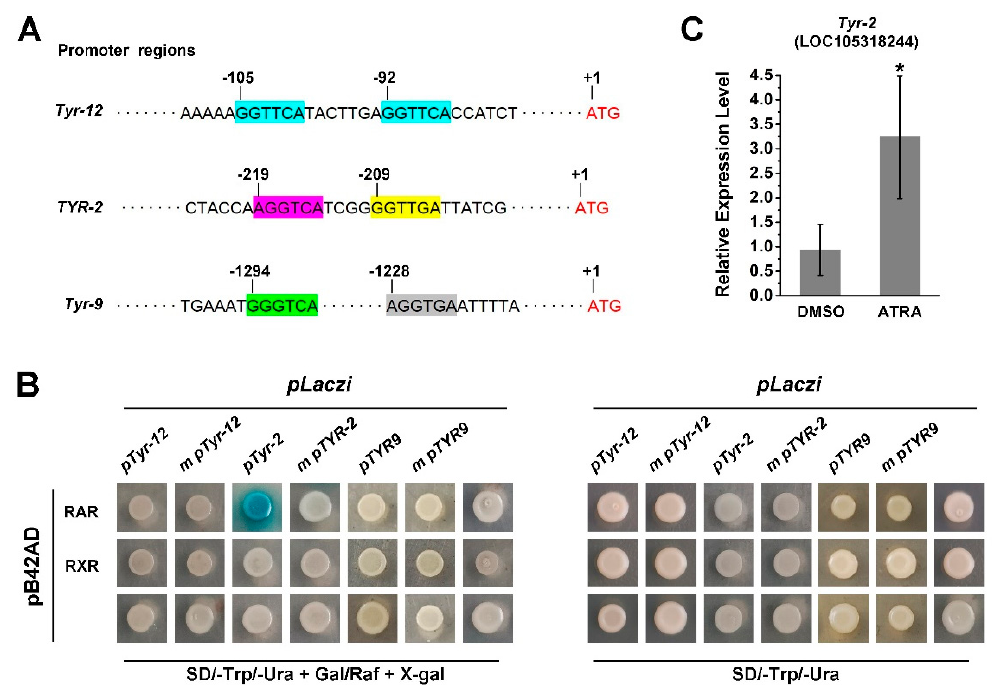
Figure 5. Cg RAR bind the promoter of Tyr-2 in yeast. ( A ) Schematic structure of RAREs in the TYR promoters. (A/G)G(G/T)(G/T)(G/C)A core sequence are marked in colored frames, and the numbers of scale plates indicate the location of these core sequence upstream from the ATG start codon; ( B ) Cg RAR combine with Tyr-2 promoter; ( C ) relative expression level of Tyr-2 upon ATRA treatment. Error bars represent ± SD ( n = 6, * p < 0.05; Student’s t test). Two (A/G)G(G/T)T(G/C)A core sequences were found in the promoter of Tyr-9 .